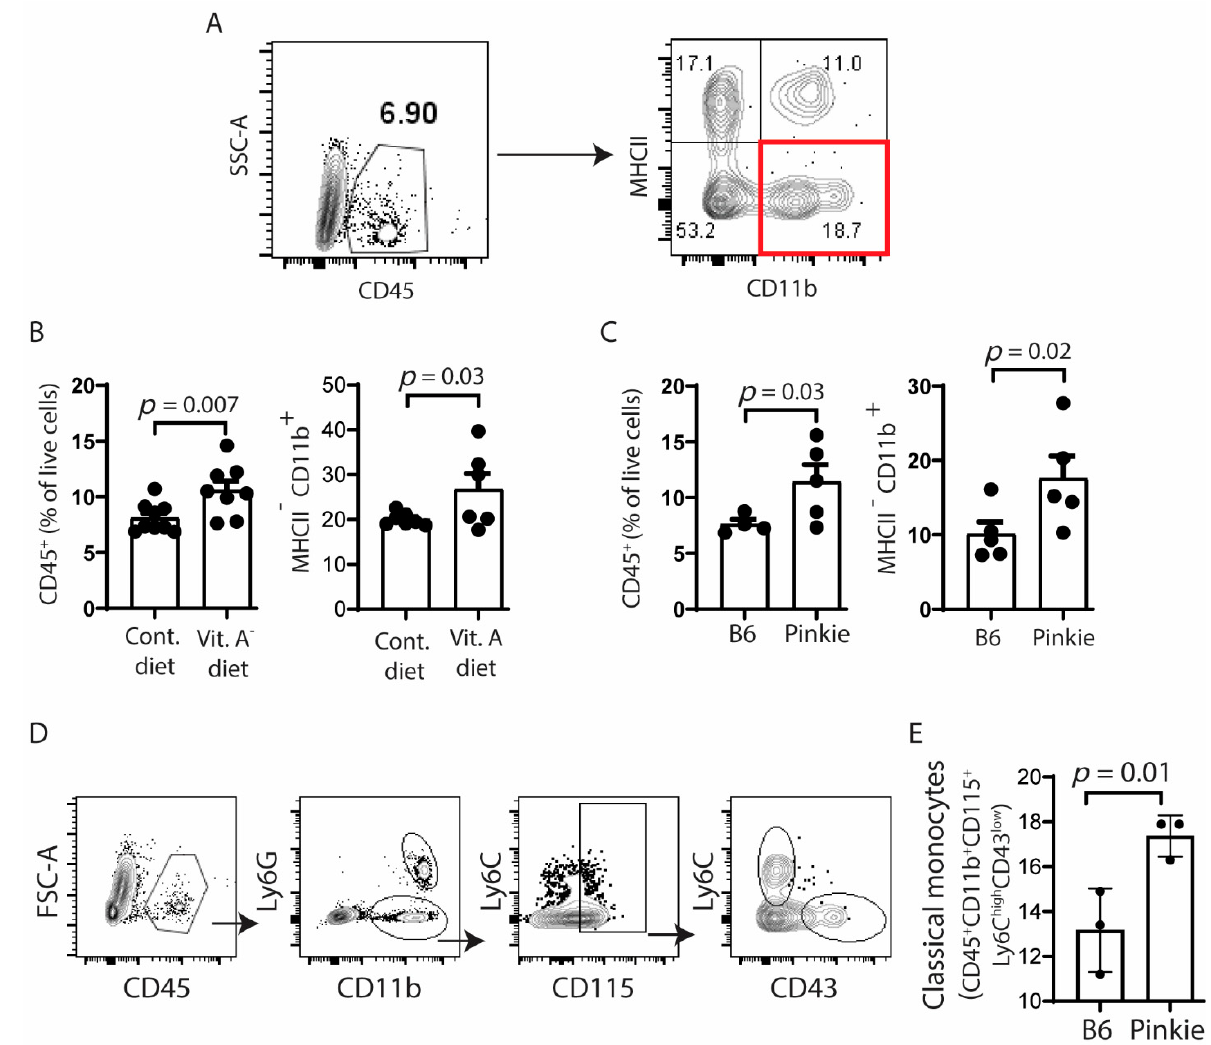
Figure 4. Recruitment of myeloid immune cells to the conjunctiva increases in vitamin A deficiency or attenuated RXR- α signaling. ( A ) Gating strategy for single cell suspension from conjunctiva of C57BL/6 (B6) mice on normal vitamin A con- taining control (Cont.) or vitamin A deficient (Vit A − ) diets or from the RXR- α mutant Pinkie strain with attenuated RXR- α signaling stained with antibodies for CD45, CD11b, and MHCII. ( B , C ) Bar graphs showing the percentages of positive cells ( n = 8/group) with each dot representing one animal; error bars indicate the standard error of mean (SEM). ( D ) Gating strategy for classical monocytes in single cell suspensions obtained from conjunctivae of C57BL/6 (B6) mice or Pinkie strains stained with antibodies for CD45, CD11b, Ly6G, Ly6C, CD115, and CD43. ( E ) Bar graph showing the percentages of classical monocytes (CD45 + CD11b + CD115 + Ly6C hi CD43 lo ) ( n = 3/group) with each dot representing one animal; error bars indicate the standard error of mean (SEM). SSC, side scatter area.